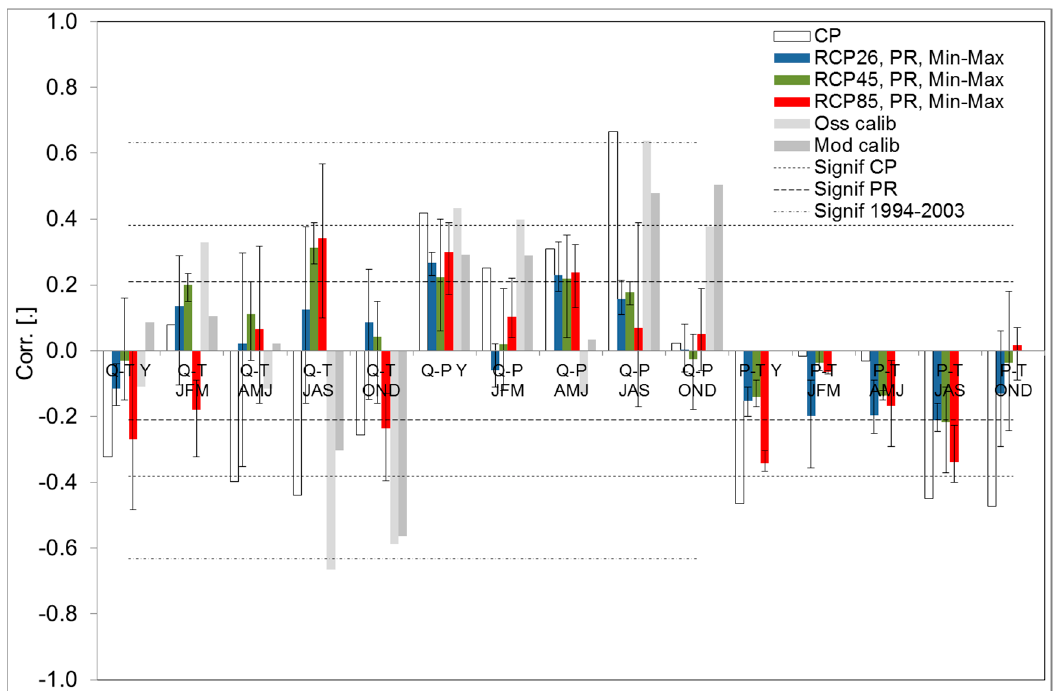
Figure 8. Projected yearly and seasonal correlation coefficients of discharge Q vs. climate drivers T, P, and between P-T until 2100, for PR period as per RCPs vs. CP period. Average RCP values reported with maximum and minimum (among GCMs). Significance values ( α = 5%) given for CP, and for PR. In grey shade correlation coefficients of Q vs. T and P during calibration period (1994–2003) for observed, and modelled series, for reference.